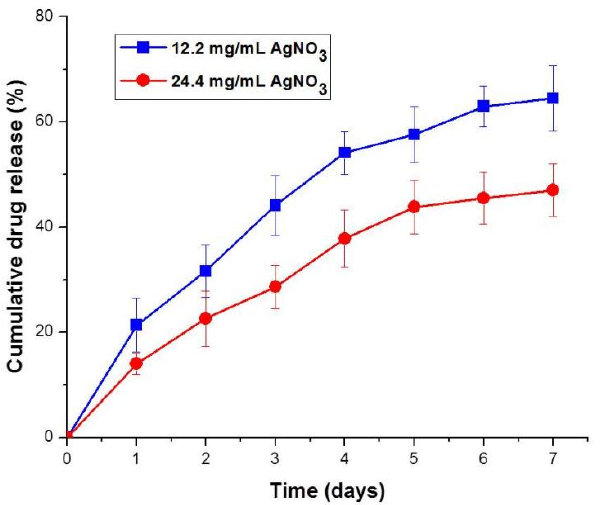
Figure 5. Adhesion of DA-GLT/AgNPs composite hydrogels to ( A ) glass, ( B ) metal, ( C ) plastic, and ( D , E ) skin.